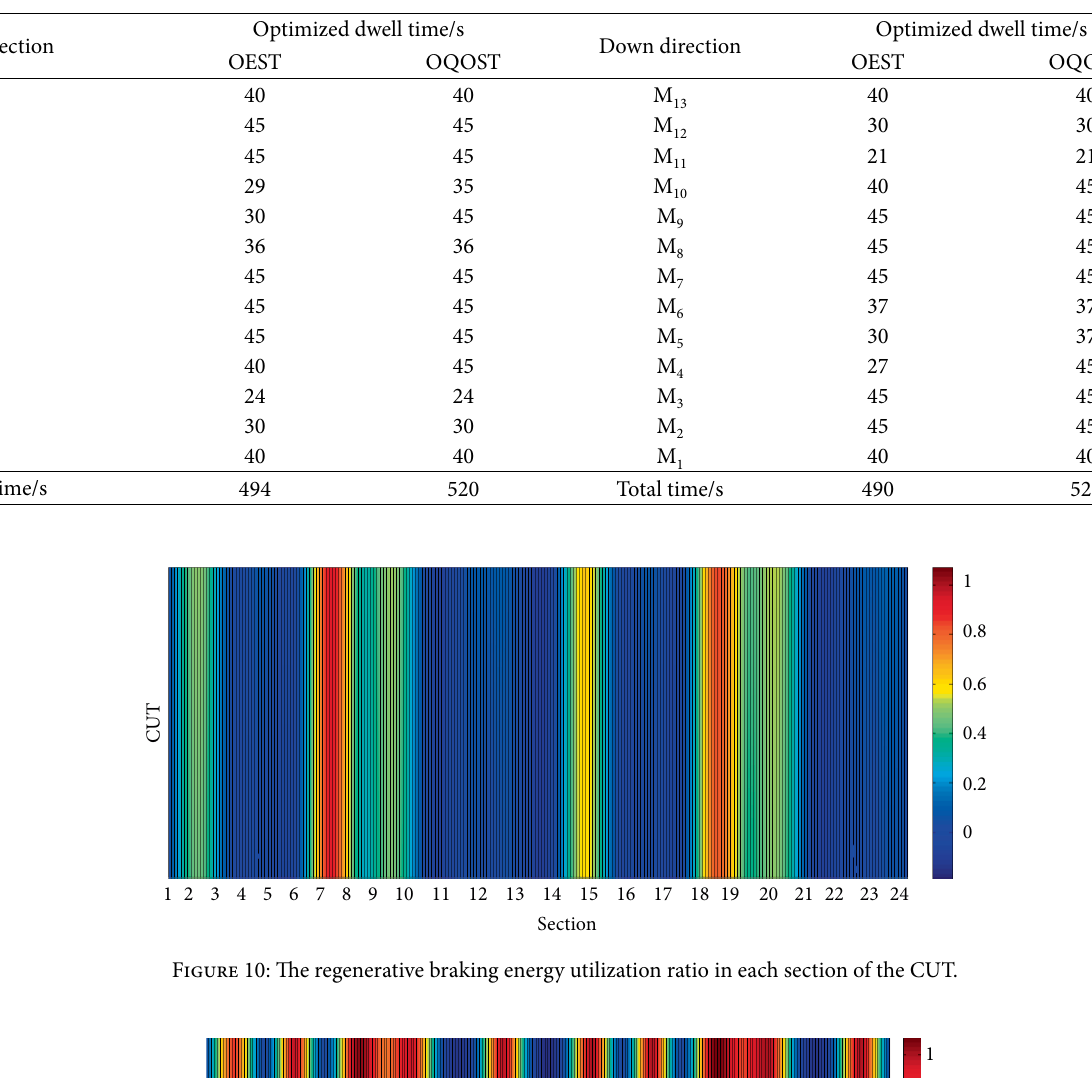
Table 9: The optimized dwell time of optimized timetable .